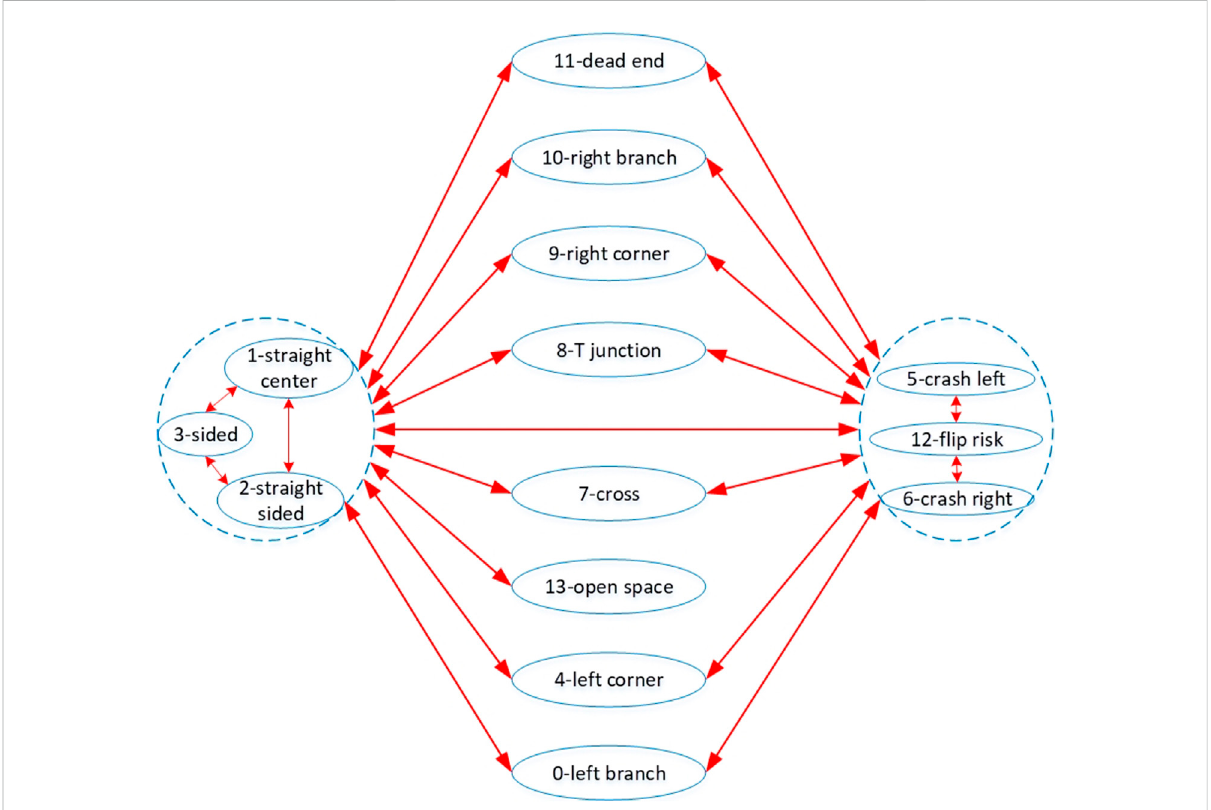
FIGURE 3 Possible robot statesinsewer pipe networks. Eacharrowrepresents apossiblestate transfer.Junction-likestates (i.e.,branches,cross,corners, dead end) do not transfer directly to each other because of their distance from each other in real sewer pipe networks. They often interchange to straight pipe states, or sided states during autonomous navigation. These three states are interchangeable but have similar conditions thus are grouped together. Another group includes the risk states (i.e., crash risks, and fl ip risk). The risk states often occur during maneuvering at